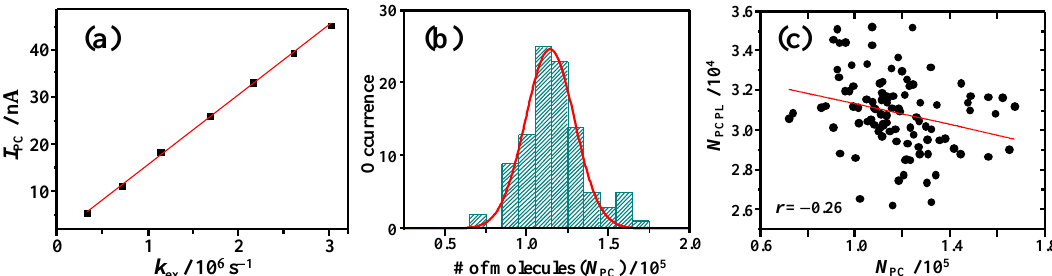
Figure 6. ( a ) Excitation rate dependence of short-circuit PC of the PC-dye. ( b ) Histogram of the number of PC-dye molecules ( N PC ) at 100 different local positions of a MK-2-DSSC. ( c ) Correlation plot between N PCPL and N PC (correlation coefficient r = −0.26).